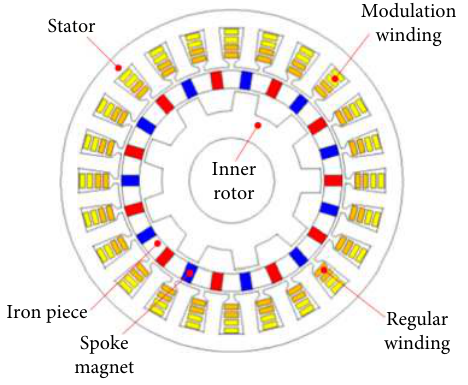
Fig. 20 Structure of the presented MP-FMM (reprinted with permission from Ref. [65], © 2020 IEEE).